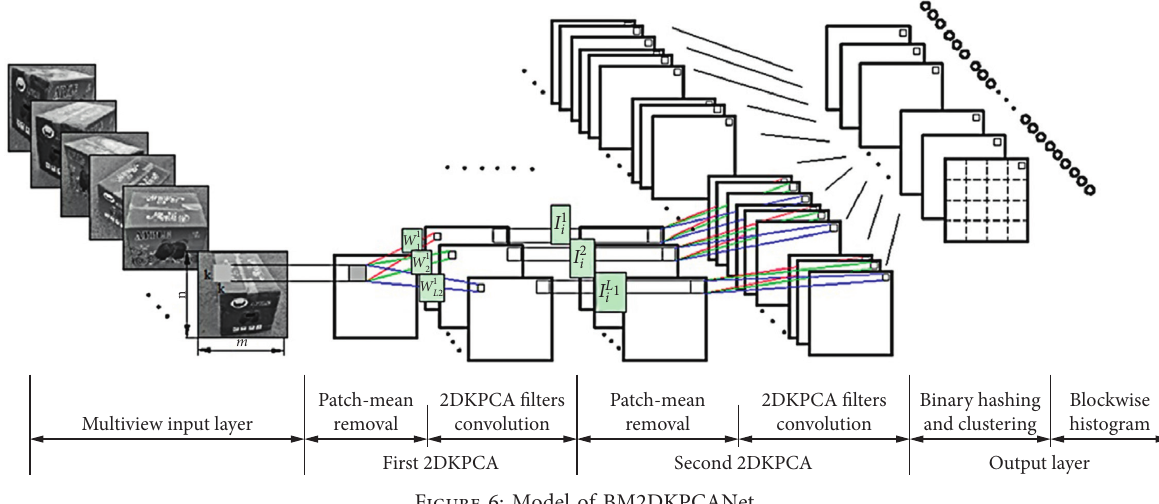
Figure 6: Model of